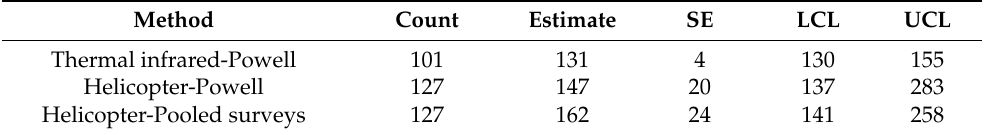
Figure 2. Detection probability as a function bison group size and presence of forested landcover type (solid = forested, dotted = not forested), North Rim of Grand Canyon National Park, USA, 2019–2021. Table 3. Raw counts, model-averaged abundance estimates, standard errors, and 95% confidence intervals for bison abundance on Powell Plateau, 11 February 2020. Models were generated from three datasets: a thermal infrared survey on Powell Plateau, a helicopter survey on Powell Plateau, and a pooled dataset from three helicopter surveys of the North Rim of Grand Canyon National Park,